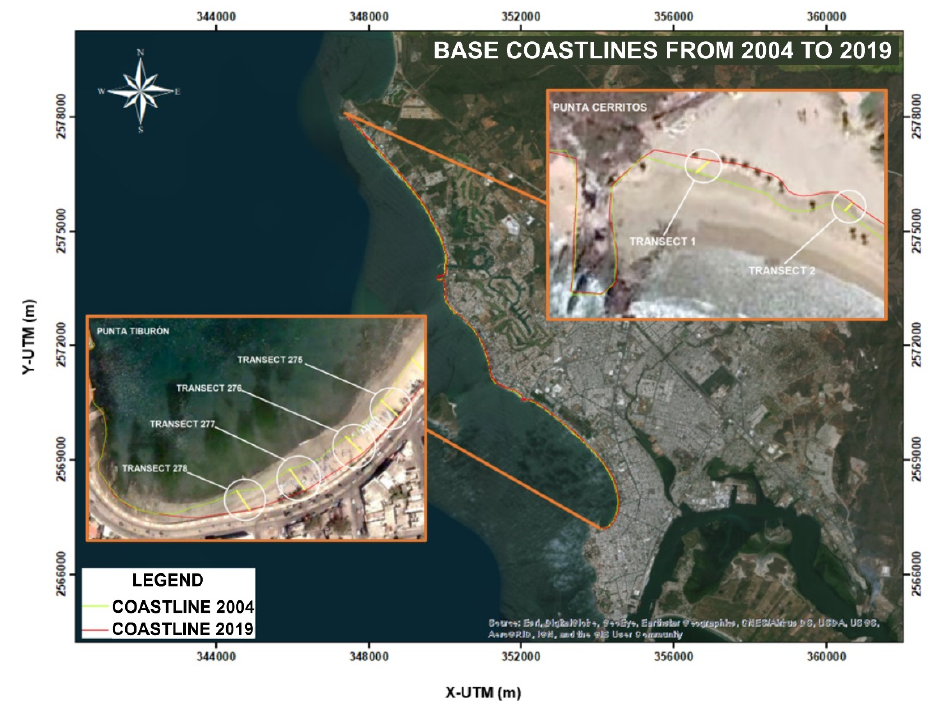
Figure 5. Aerial views of the shoreline in 2004 and 2019, showing the locations of transects 1–2 and 275–278.